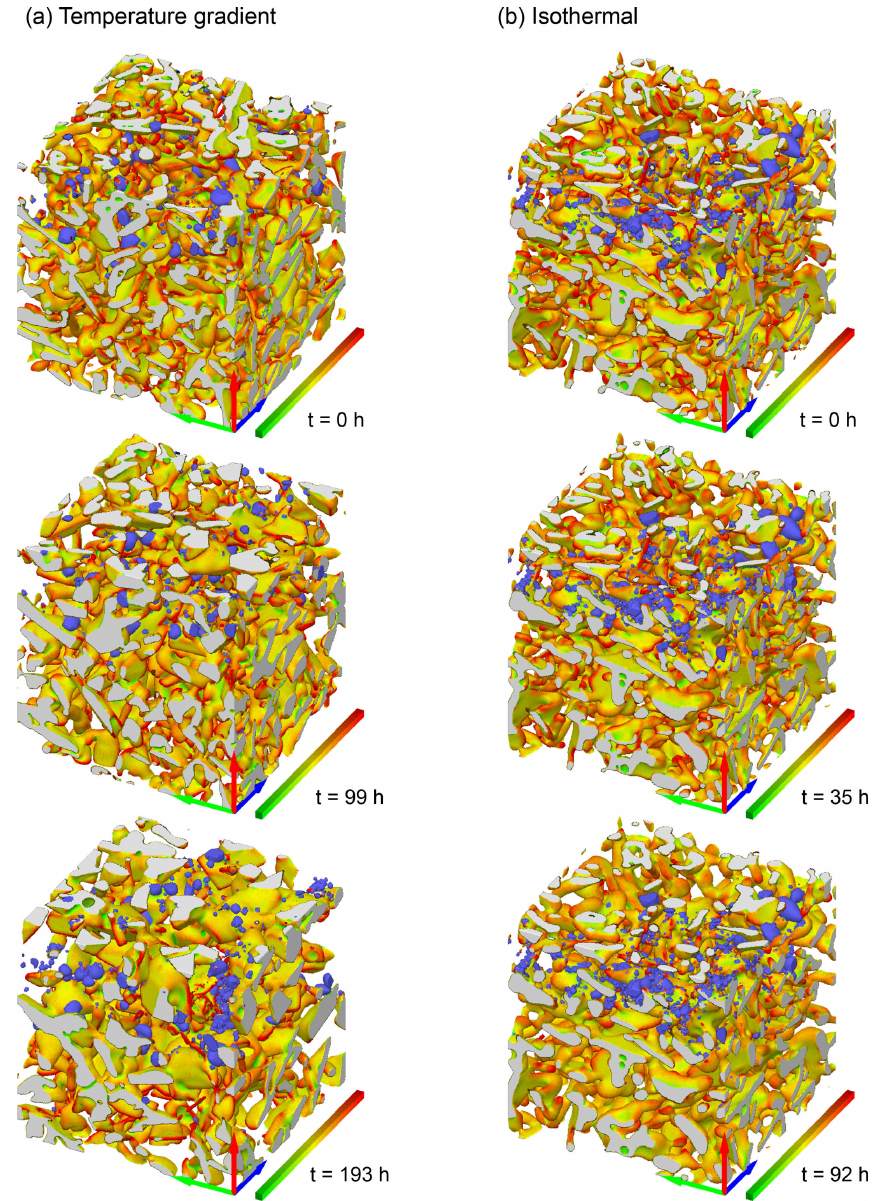
Figure 1. Microstructure of the samples at initial, intermediate and final stages. Only subvolumes of size 3 3 mm 3 are shown with a ver- tical orientation corresponding to that of the experiment. The color map represents the mean curvature from green ( − 25mm − 1 ) to red ( + 25mm − 1 ) and the colored bar is 3mm long. The dust particles are shown in blue.